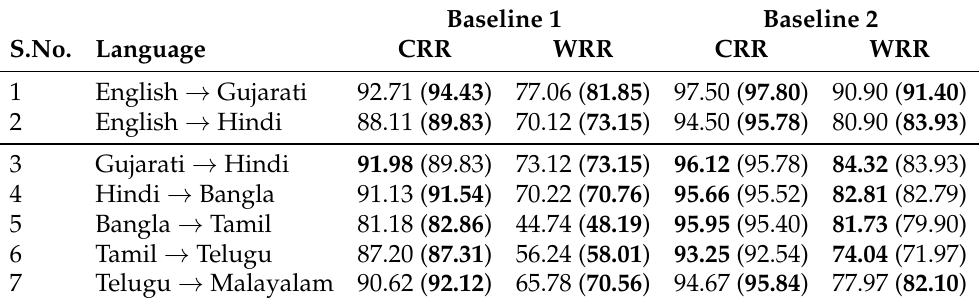
Table 3. Results of Transfer Learning (TL) on synthetic datasets. Parenthesis contain results on target languages w/o TL. TL among Indic scripts improves Baseline 2